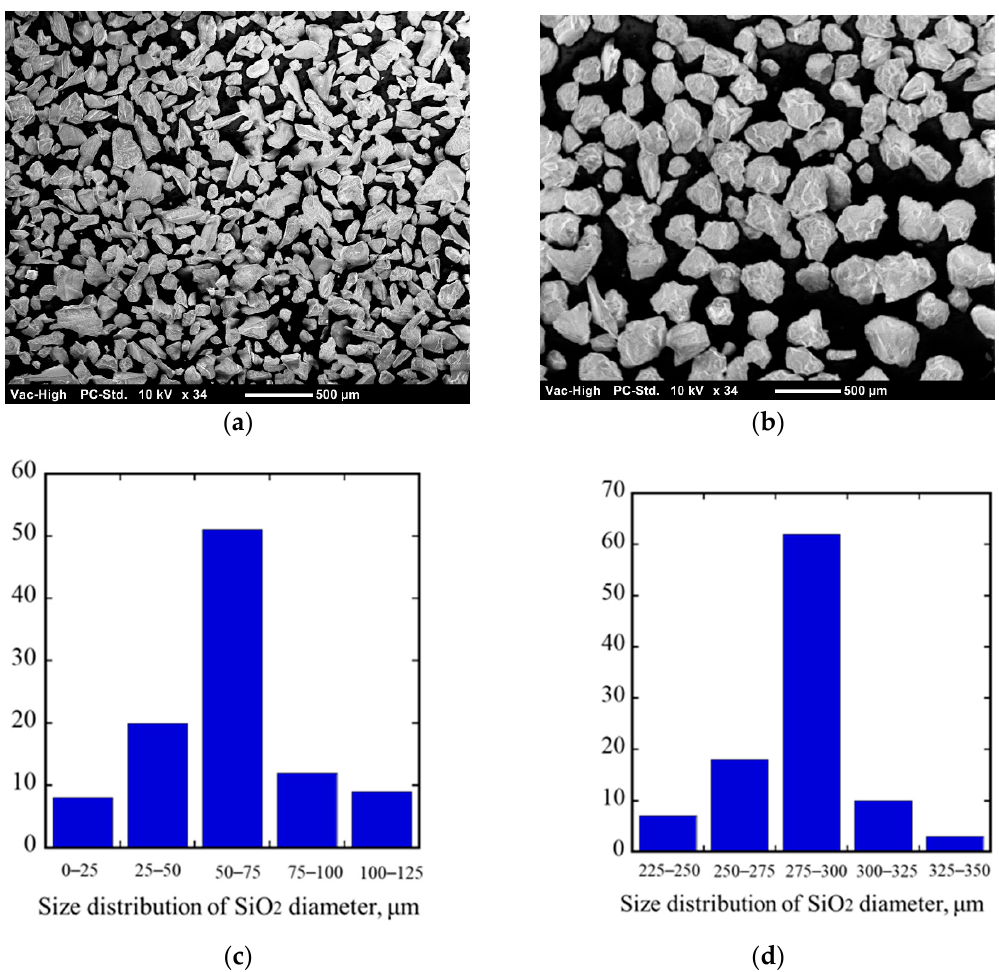
Figure 2. A rubber wheel three-body abrasive wear machine test according to the ASTM G65 standard.